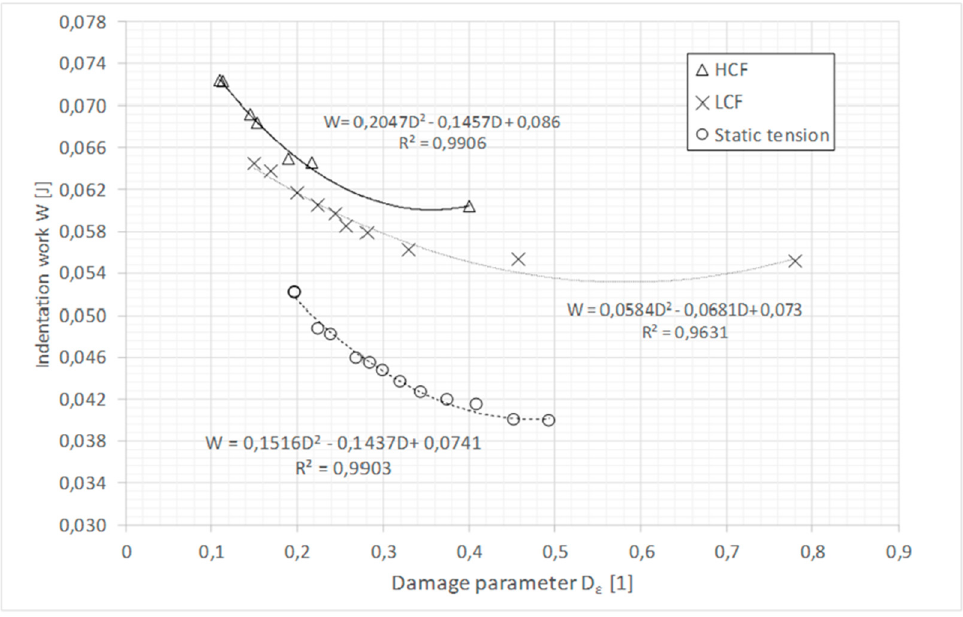
Figure 12. Indentation work as the function of damage parameter for all applied loading regimes.